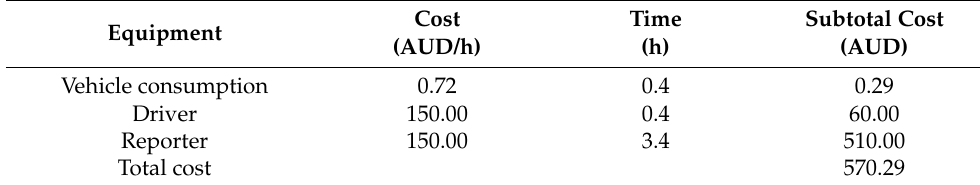
Table 4. Cost breakdown of traditional method.